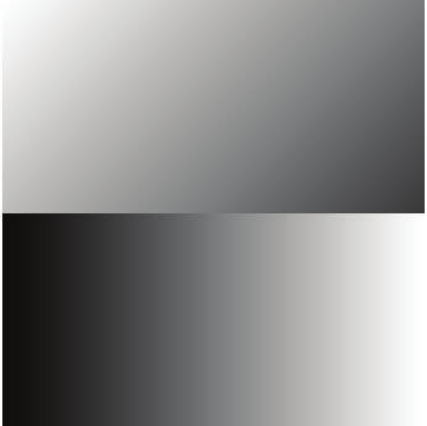
Figure 2: Phase distribution of two wavefronts with unequal and opposite